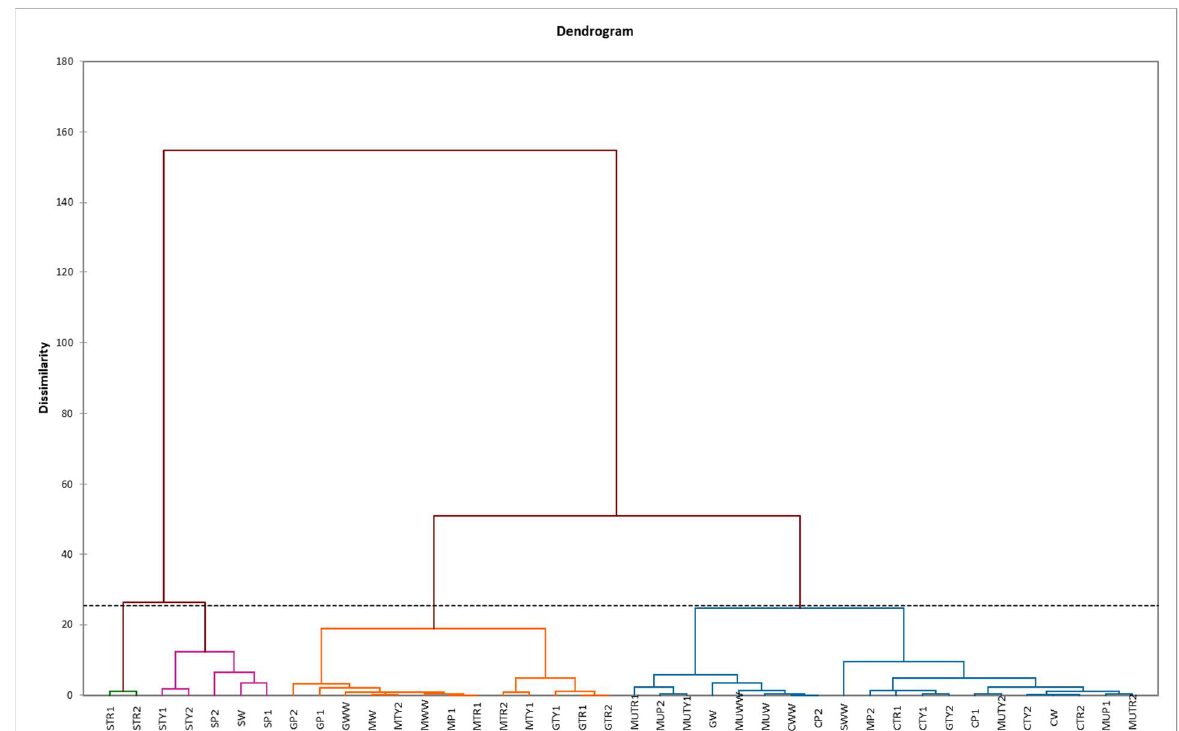
Figure 4. Hierarchical clustering analysis (HCA) of different mints influenced by foliar application of amino acids (MW— M. spicata “Moroccan” water, MWW— M. spicata “Moroccan” non-sprayed, MP1— M. spicata “Moroccan” phenylalanine 100 mg L −1 , MP2— M. spicata “Moroccan” phenylalanine 200 mg L −1 , MTR1— M. spicata “Moroccan” tryptophan 100 mg